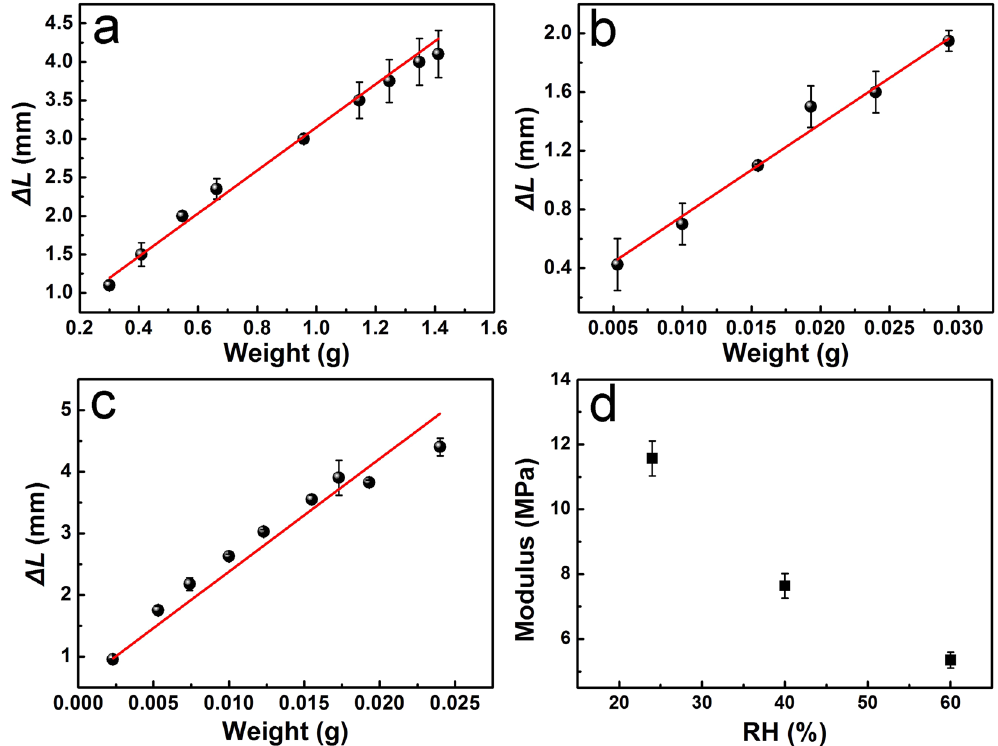
Figure 4. ( a – c ) Dependence of the moving distance of actuators ( Δ L ) on the mass of the weight that hangs on to the actuator when the RH is ( a ) 36%, ( b ) 75%, and ( c ) 90%. ( d ) Compressive modulus of the PVA layer at different RHs measured by AFM.